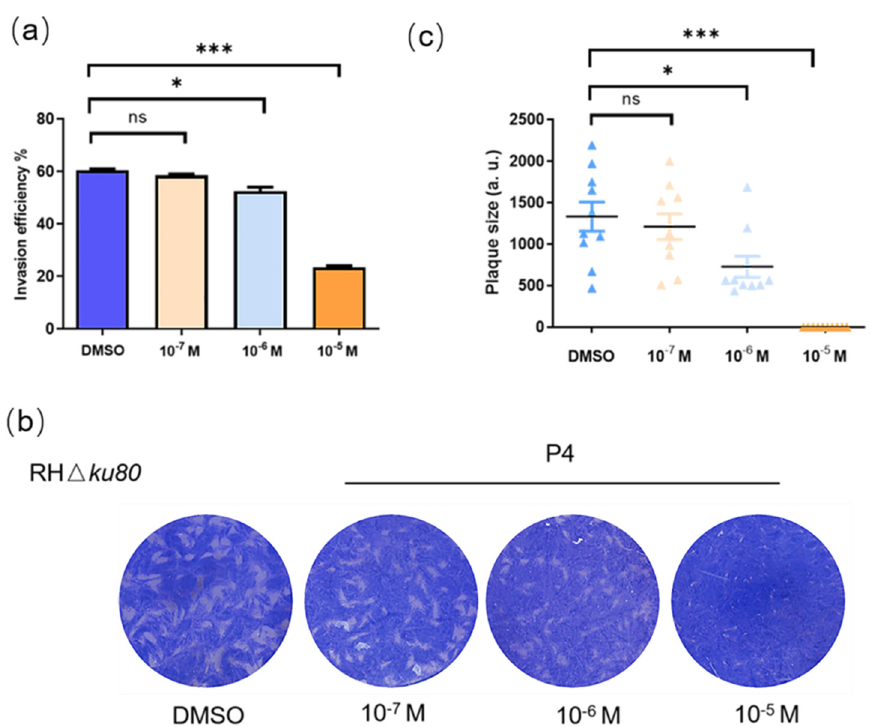
Figure 1. Percentage of infected cells after infection with tachyzoites: ( a ) Percentages of intracellular RH ∆ ku80 tachyzoites were calculated to determine the invasion efficiency in serum-free medium treated with progesterone at a concentration of 10 − 7 M, 10 − 6 M and 10 − 5 M. Control: medium with the same final concentration of DMSO (ns, not significantly, * p < 0.05, *** p < 0.001); ( b ) HFFs were infected with 150 tachyzoites, cultured with different concentrations of progesterone, and incubated for 7 days without any perturbation to allow plaque formation. The monolayer was stained with crystal violet. Control: medium with the same final concentration of DMSO; ( c ) Quantitative analysis of plaque area and number in the RH Δ ku80 strain treated with 10 − 7 M, 10 − 6 M, and 10 − 5 M progesterone. The plaque formation in the progesterone treatment group was significantly inhibited with the increase in progesterone concentration. Plaque assays were carried out three times independently (ns, not significantly, * p < 0.05, and *** p < 0.001).